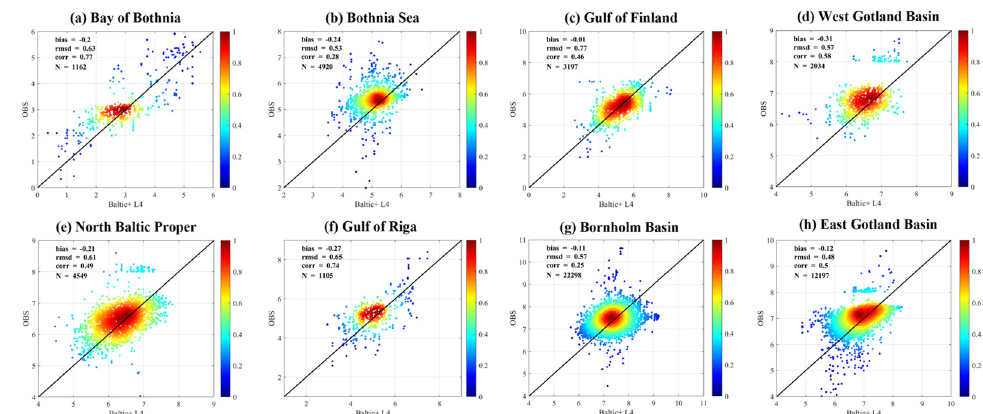
Figure 6. Density plot of 8-day SMOS BEC L4 versus collocated in situ SSS measurements for the eight zones of the Baltic Sea, including ( a ) the Bay of Bothnia, ( b ) the Bothnia Sea, ( c ) the Gulf of Finland, ( d ) the West Gotland Basin, ( e ) the North Baltic Proper, ( f ) the Gulf of Riga, ( g ) the Bornholm Basin, ( h ) the East Gotland Basin. The unit is in PSU for biases and RMSDs.